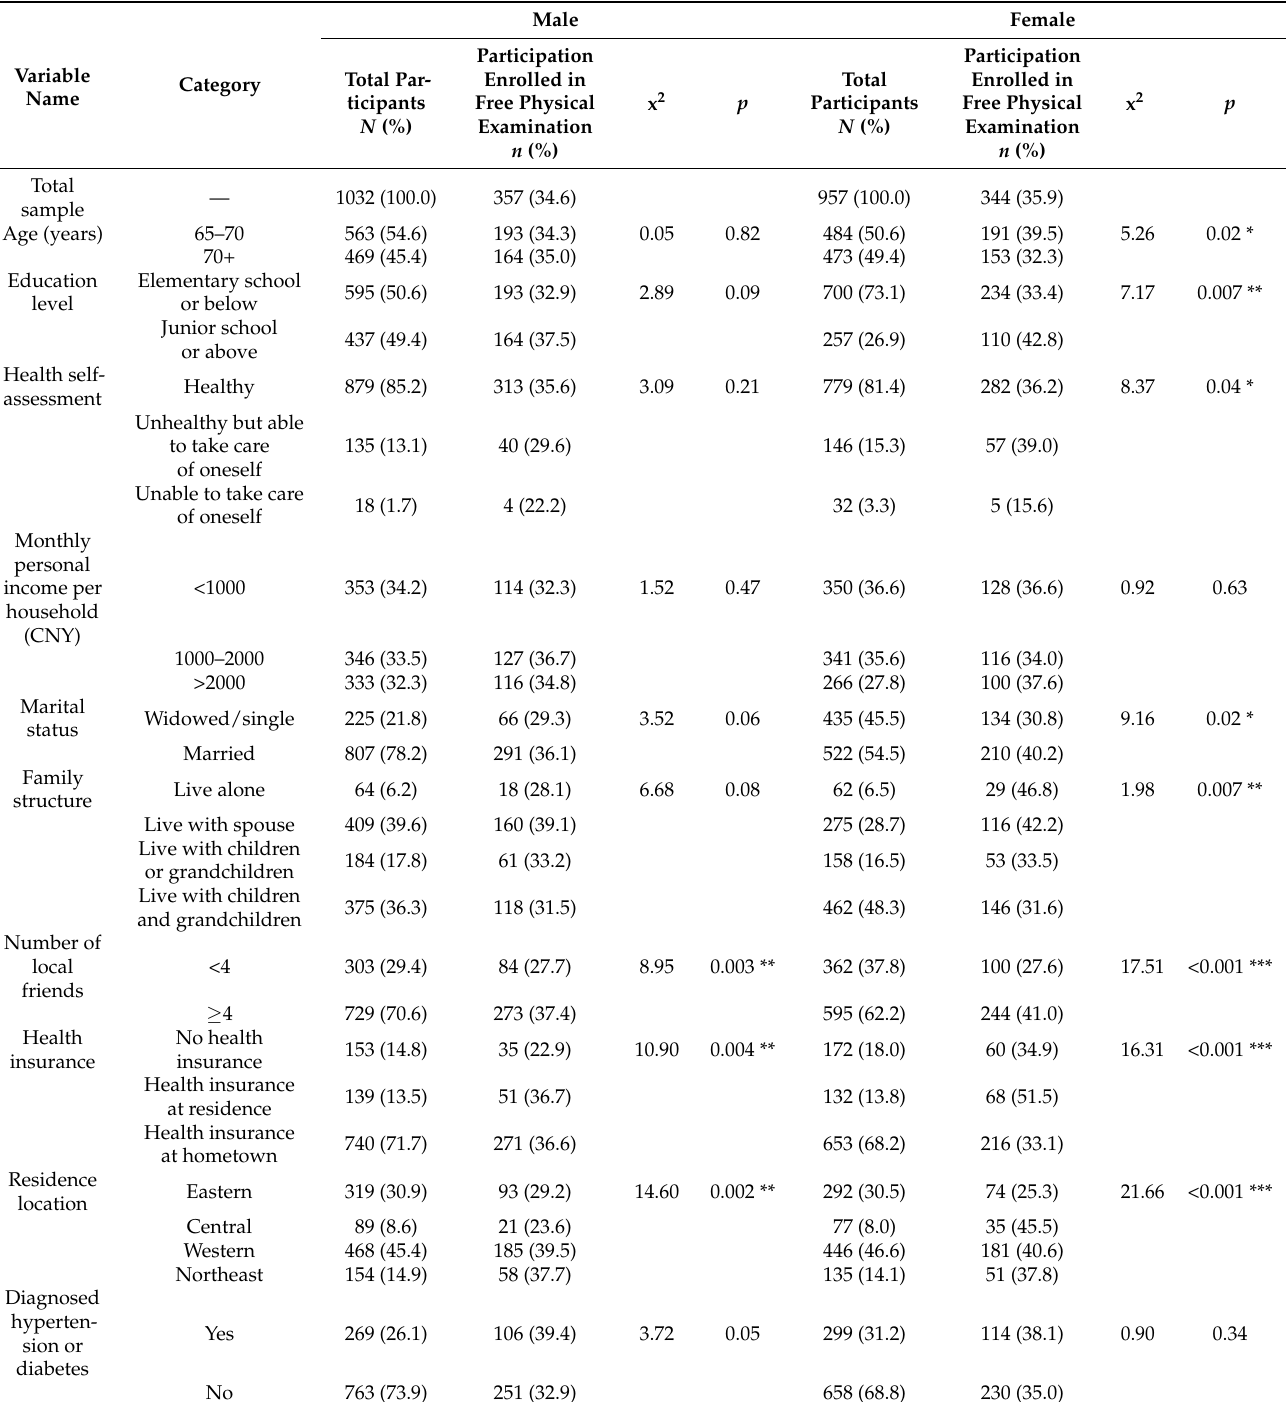
Table 1. Participants’ characteristics in terms of enrolment in the free physical examinations among older migrants ( N =